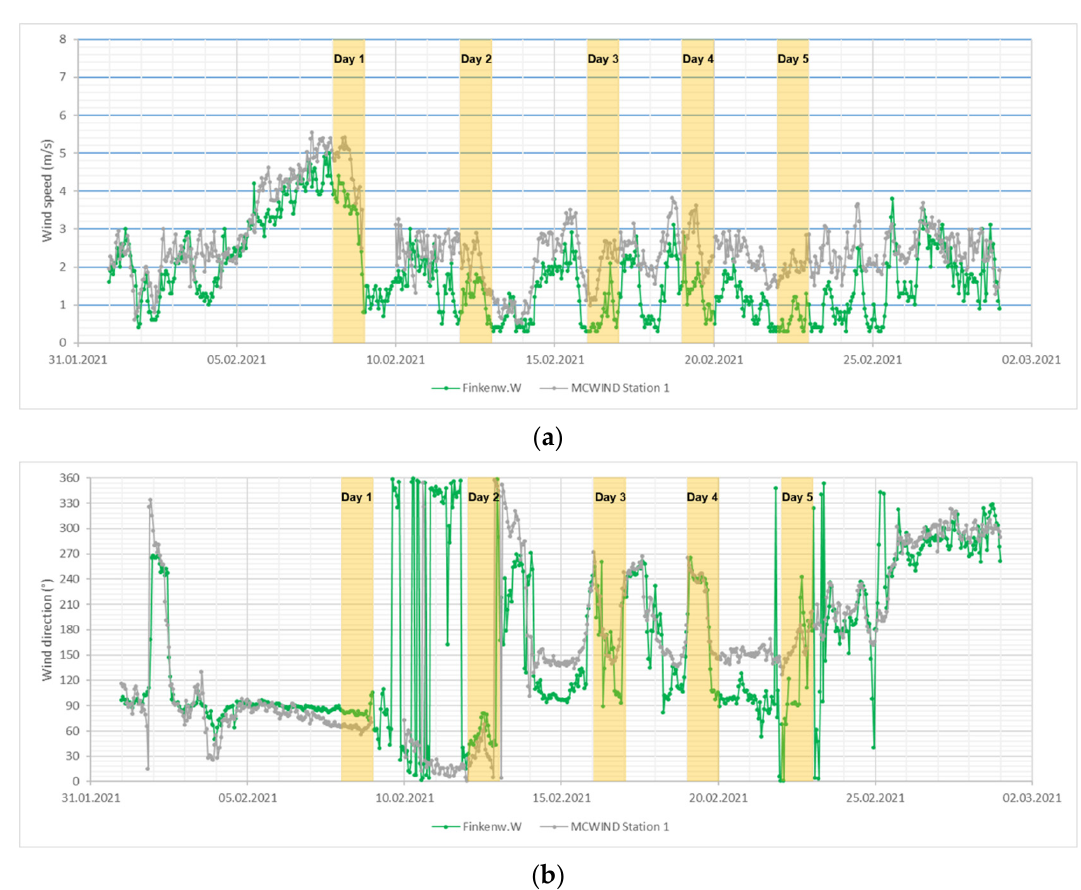
Figure A3. Comparison of ( a ) wind speed (m/s) and ( b ) wind direction (°) used in the model simulation against measurements at weather station Finkenwerder West in Hamburg during February 2021. Missing model data on 9 February 2021. Measurement data obtained from the air quality monitoring network of the city administration (Luftmessnetz Hamburg (HaLM); https://luft.hamburg.de/clp/meteorologie/clp1/, accessed on 8 September 2021). The transparent orange bars highlight the selected days that were investigated in this study.